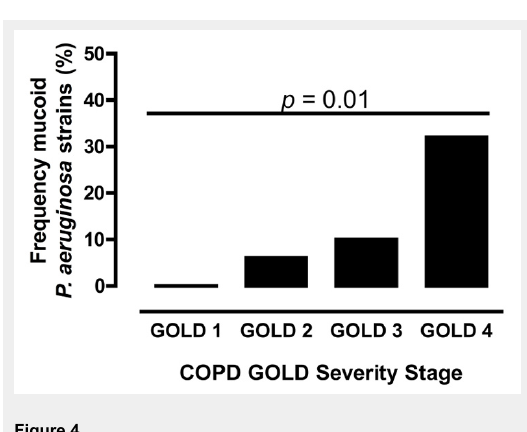
Frequency of mucoid phenotype in P. aeruginosa isolates from COPD patients stratified according to severity of disease (GOLD1-4). p -values were obtainedutilising the Chi-square test.